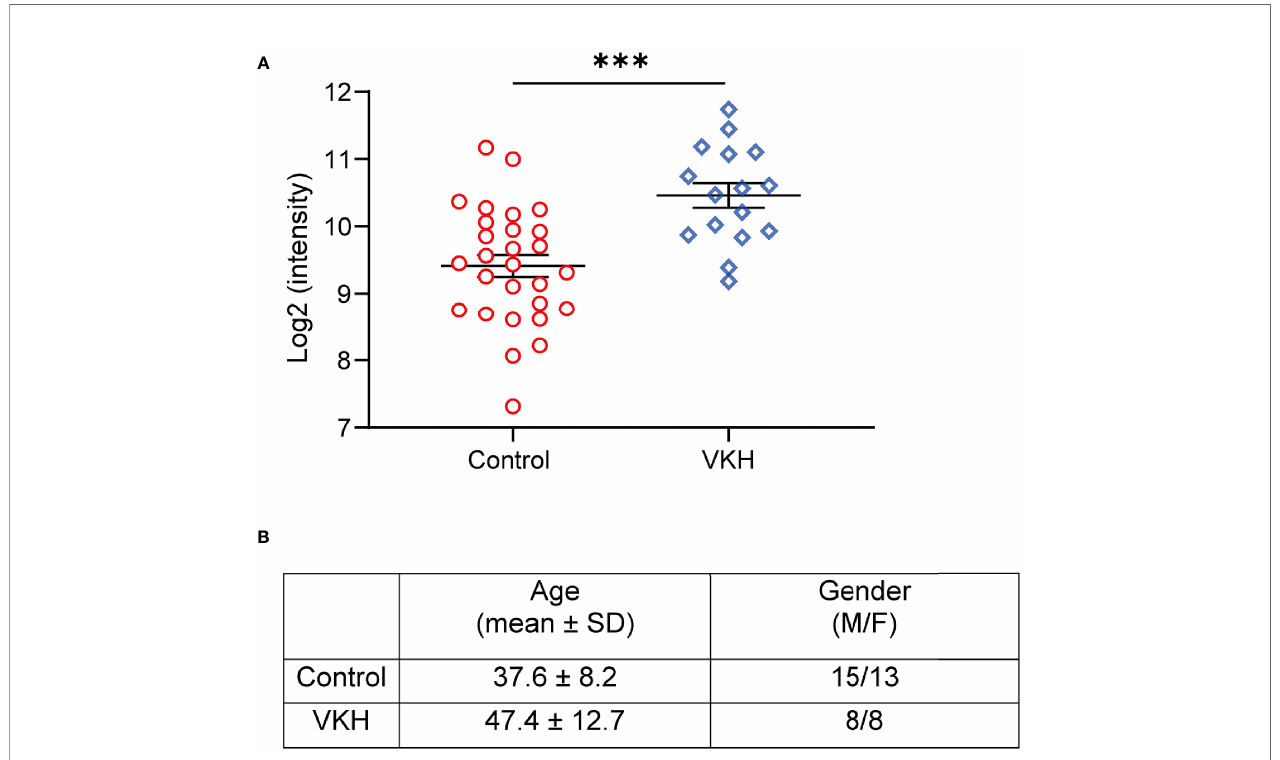
FIGURE 1 | Proteomics analysis of VKH patients identi fi es upregulation of kallistatin protein. The 48 participants with primary diagnosis (Control: n = 28; VKH: n = 16) were enrolled in the proteomics analysis. (A) The plasma levels of kallistatin protein in controls and VKH patients were analyzed by mass spectrometry. (B) Demographics of VKH patients and control participants. The mass spectrometry data were log2 transformed and quantile normalized using the R programming language package. Differential analysis of protein expression was performed using t test. Data are shown as mean ± SEM. ***P <